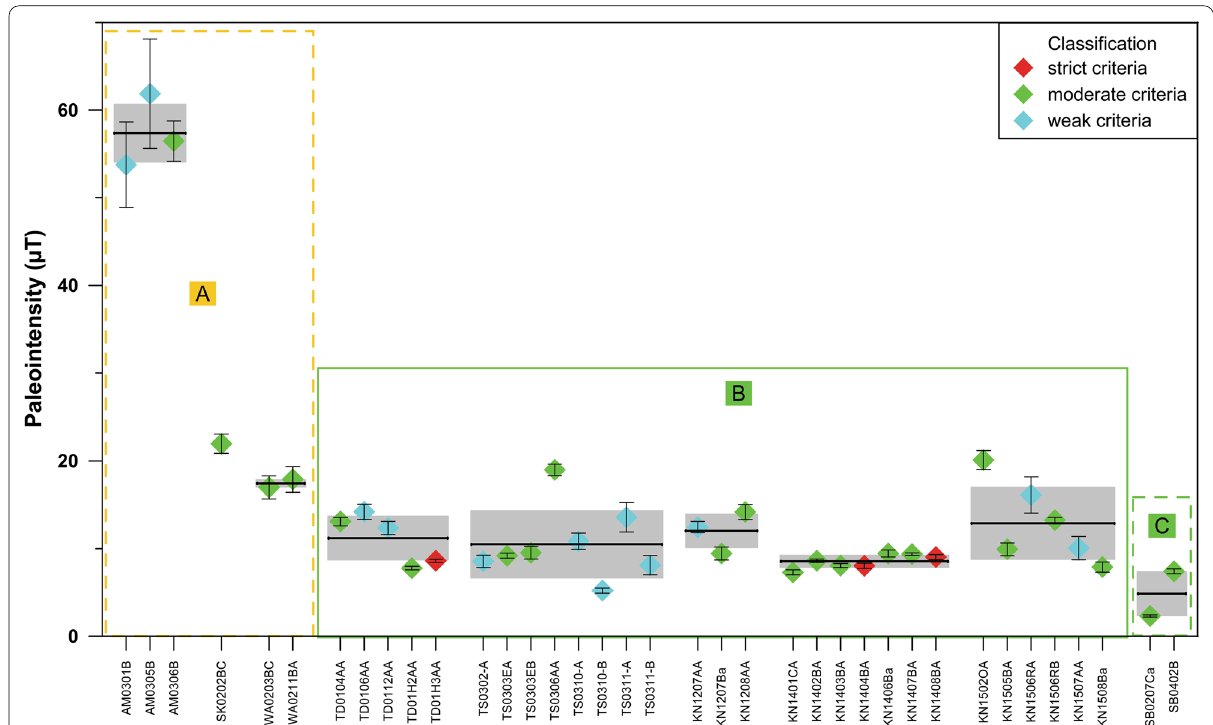
Fig. 12 Summary of paleointensity results. Individual values and site means are plotted with error bars/bands versus specimen names for the 3 VGP clusters (see Fig. 10)